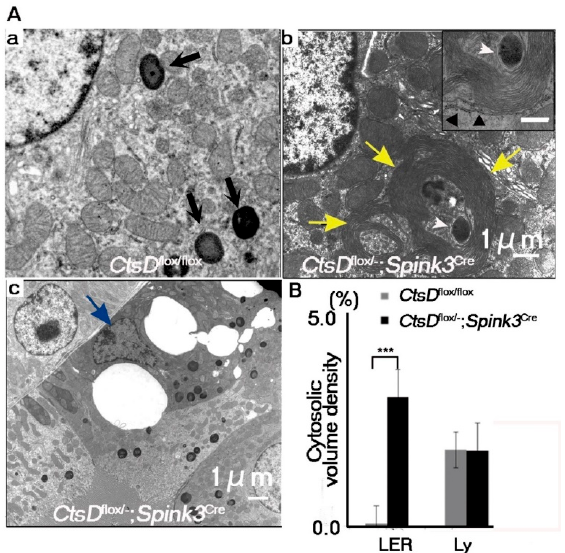
Figure 3. Abnormal autophagy-related structures increased in CtsD -deficient renal proximal tubular epithelial cells. ( A ) Electron microscopic images of CtsD flox/flox ( a ) and CtsD flox/ − ; Spink3 Cre ( b , c ) mice. Black arrows in CtsD flox/flox ( a ) indicate normal lysosomes. Cells derived from CtsD flox/ − ; Spink3 Cre contained electron-dense structures with fingerprint profiles (insert) in the apical regions ( b ). Cells derived from CtsD flox/ − ; Spink3 Cre mice often possessed autophagic vacuoles and lamellarly/concentrically arranged endoplasmic reticula (LER) ( b , yellow arrows). In some case, at the center of LER, autophagic vacuoles/autolysosomes were detected ( b , white arrowheads). Outermost layers of LER were attached by ribosomes ( b , insert, black arrowhead). Epithelial cells appeared to be dying ( c , blue arrow). ( B ) Quantification of membranous structures via the point-counting method. LER, lamellarly/concentrically arranged endoplasmic reticula; Ly, lysosomes. The number of fields totaled 30 from each mouse. The results represent the mean, SEM. *** p < 0.001. 2.3. Cathepsin D-Deficiency Increased the Sensitivity Against Renal Ischemia/Reperfusion Injury in Renal Proximal Tubular Epithelial Cells of the CtsD fl ox/ − ; Spink3 Cre Mouse